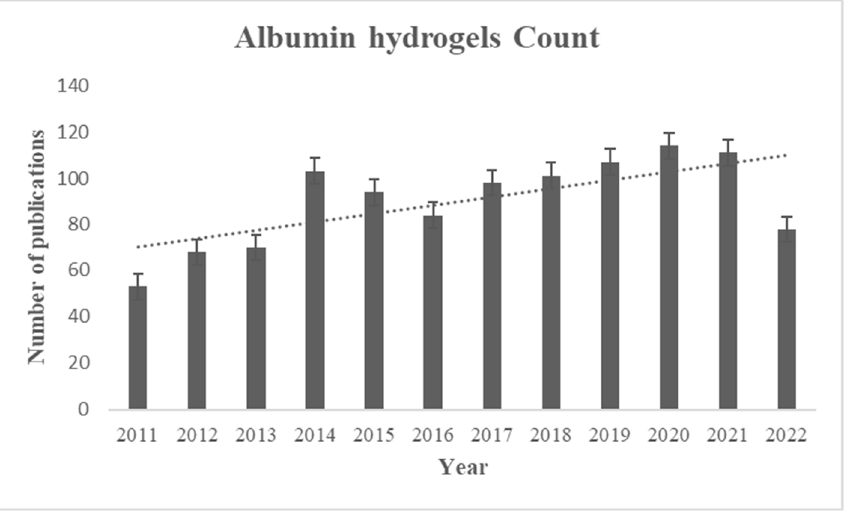
Figure 1. The number of publications of albumin-based hydrogels after 2011 using albumin hydrogels as a keyword to search in the PubMed database.